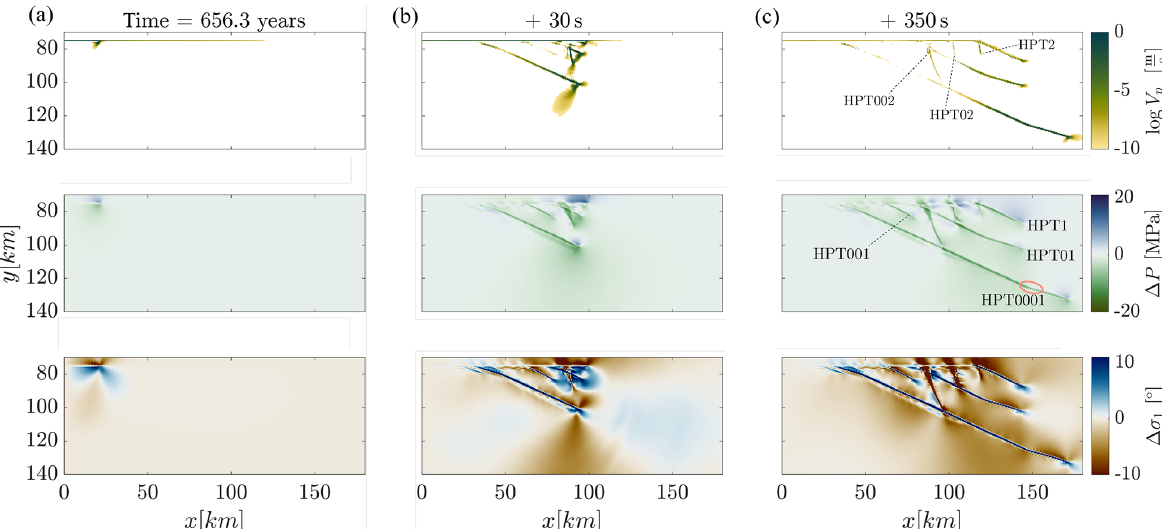
Figure 9. Model HPT with higher background pressure ( P B = 40MPa) and increased crustal thickness ( T = 40km). Plotted are the logarithm of the slip velocity V p , the pressure difference (cid:49)P between initial background pressure P B and dynamic pressure P , and the dynamic change in σ 1 orientation (cid:49)σ 1 for three different instants in panels (a) , (b) and (c) , respectively. Different fault branch names are indicated in (c) . The red circle in (c) marks the bend of branch HPT0001 due to an aseismic transition phase between two successive